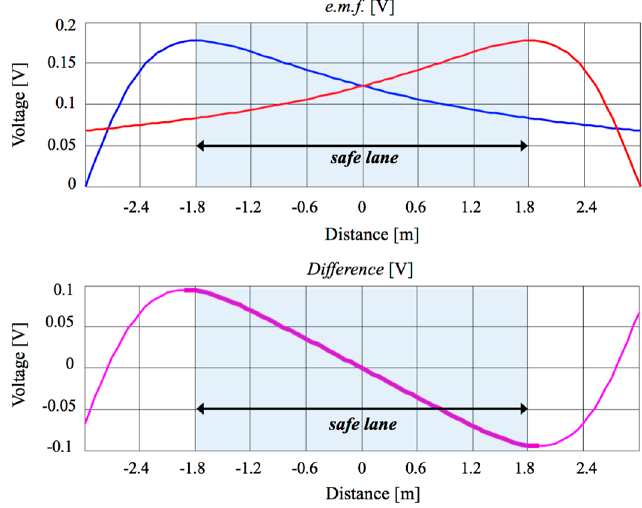
Figure 3. Top: theoretical evaluation of the induced electromotive force e.m.f. , according to (Equation (1)). The blue and red lines refer to the external and internal wire respectively. Bottom: difference of the received signals.